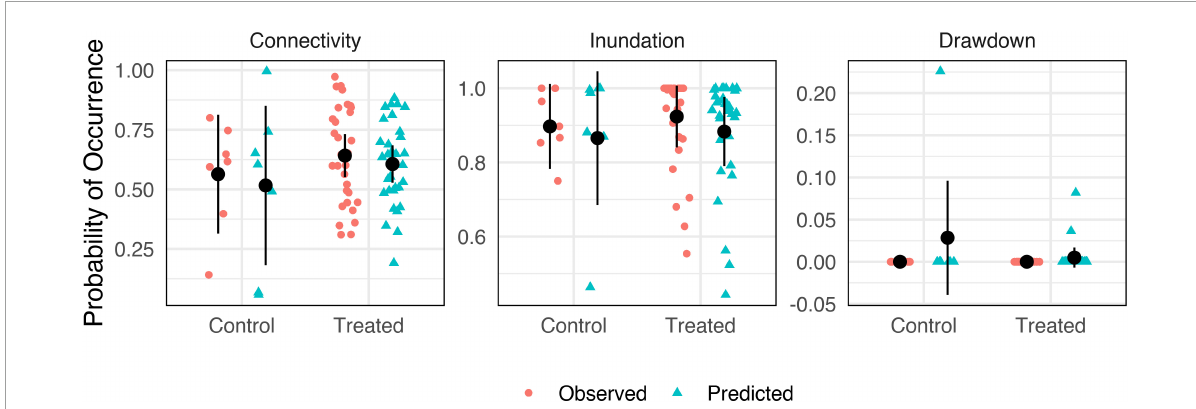
FIGURE4 Tests comparing predicted probability of occurrence for critical ecohydrological thresholds (CEHT). Reported values show the seasonal probability of daily water level exceeding the respective CEHT. Control and treated conditions refer to observed control and treated conditions or predicted modeled black ash and modeled non-forested conditions. Black point and error bar represent estimated marginal mean and its 95% confidence interval. Individual points represent data observed or simulated for 1 year at one site. All data presented were derived only from the withheld test period for each